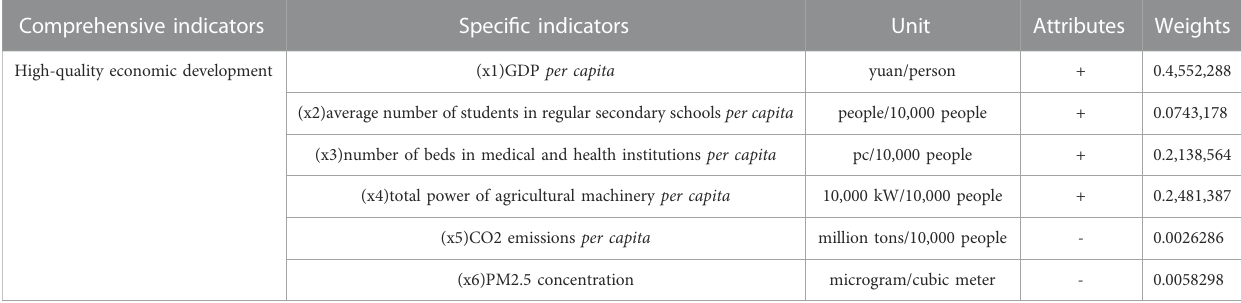
TABLE 1 Evaluation index system and weight results of high-quality economic development. Comprehensive